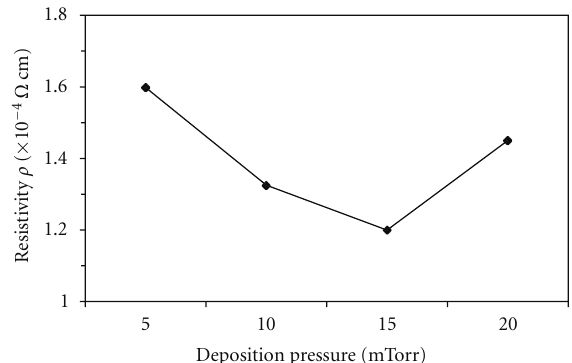
Figure 8: Resistivity of the ITiO film with variations of Ar gas pressure.